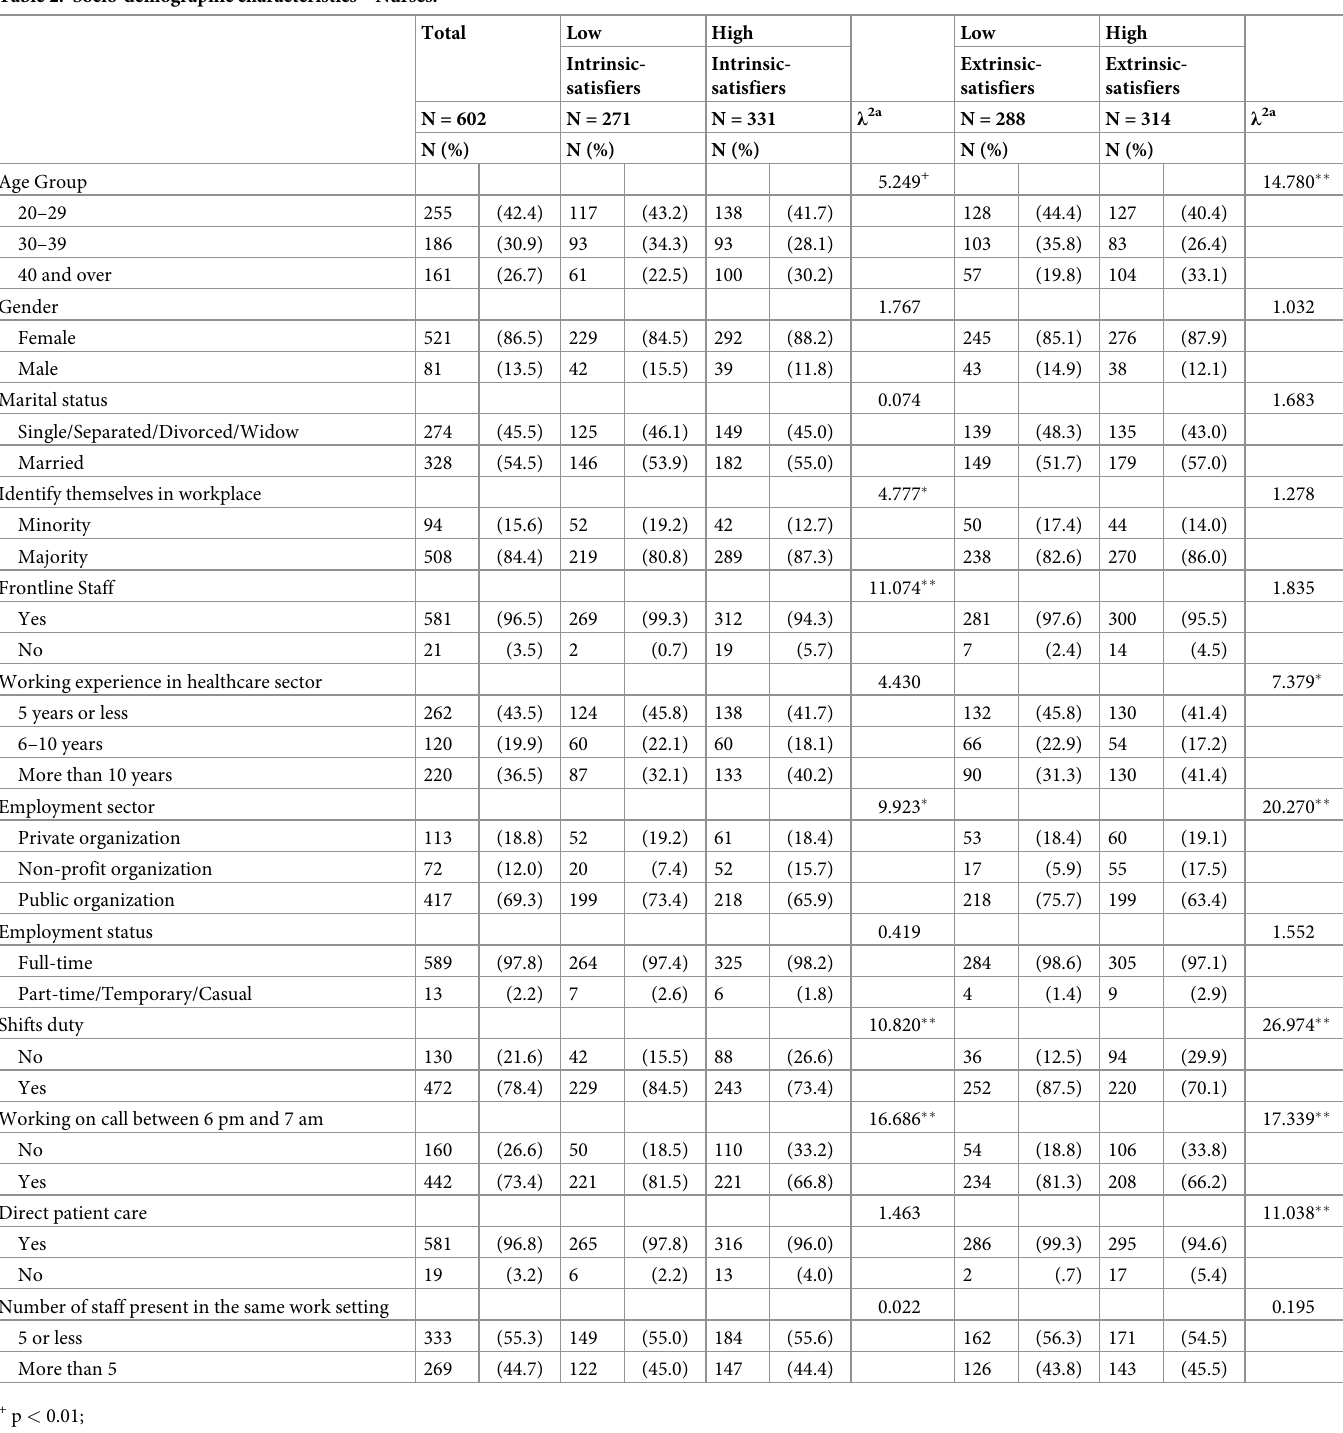
Table 2. Socio-demographic